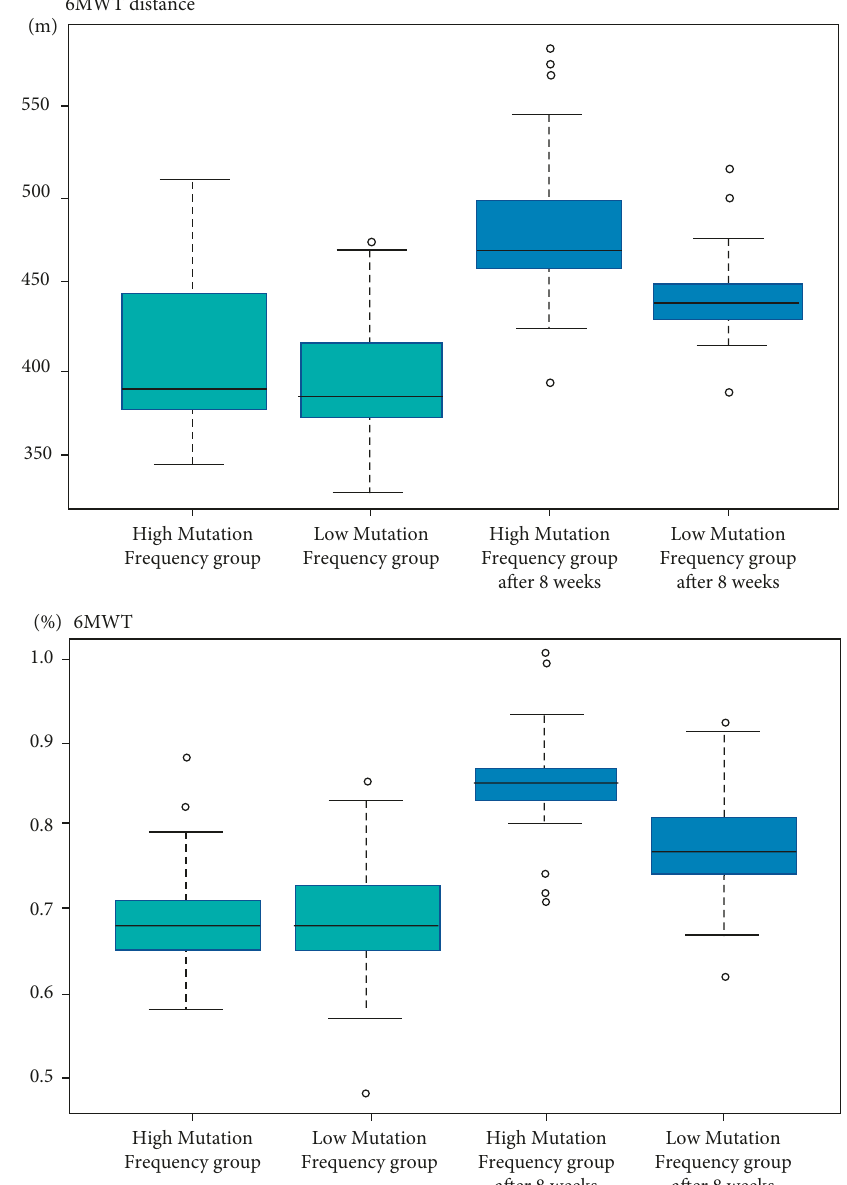
Figure 4: 6MWT distance and 6MWT% before and after the 8-week exercise